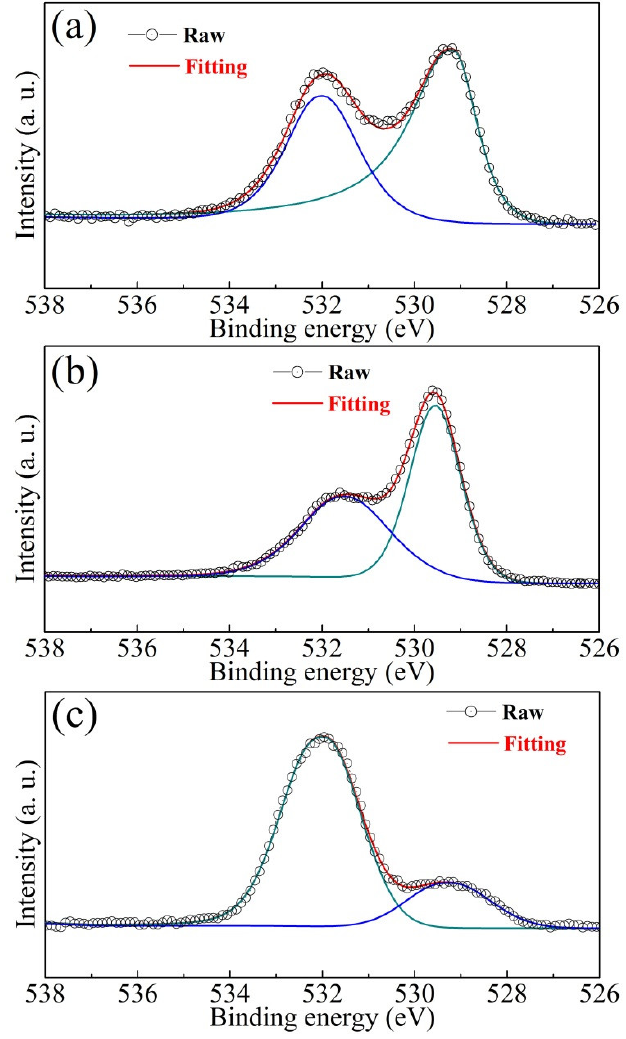
Figure 5. O 1s valence states in the BCTZ-NY x ceramics doping with yttrium contents ( x ) of ( a ) 0, ( b ) 0.18, and ( c ) 0.30 mol%.